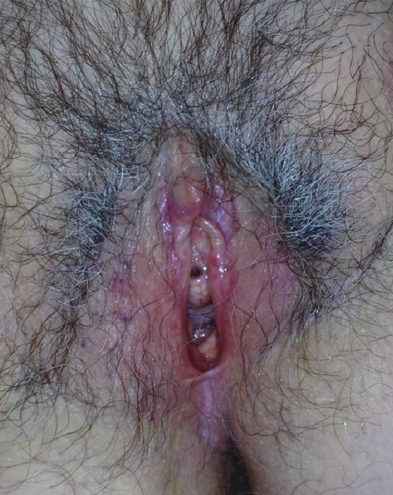
Figure 2: Lichen sclerosus with porcelain-white atrophic scarring, erosions, and hemorrhages in the genital area. (1 : 160 titer) antinuclear antibody (ANA). Detection of serum